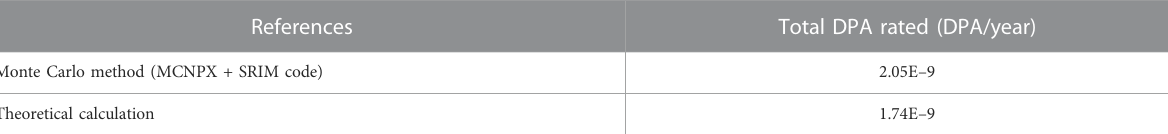
TABLE 3 Comparison between the DPA production rate estimated by theoretical calculation and Monte Carlo results.